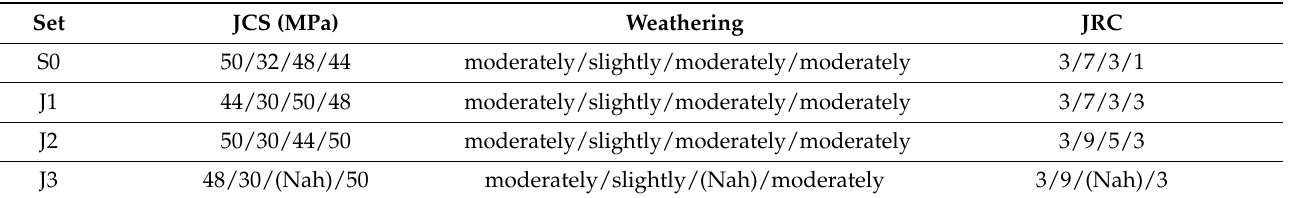
Table 6. Site-dependent discontinuity properties (site 1/ site 2/ site3/ site 4), including UCS, surface weathering condition, surface shape and JRC.